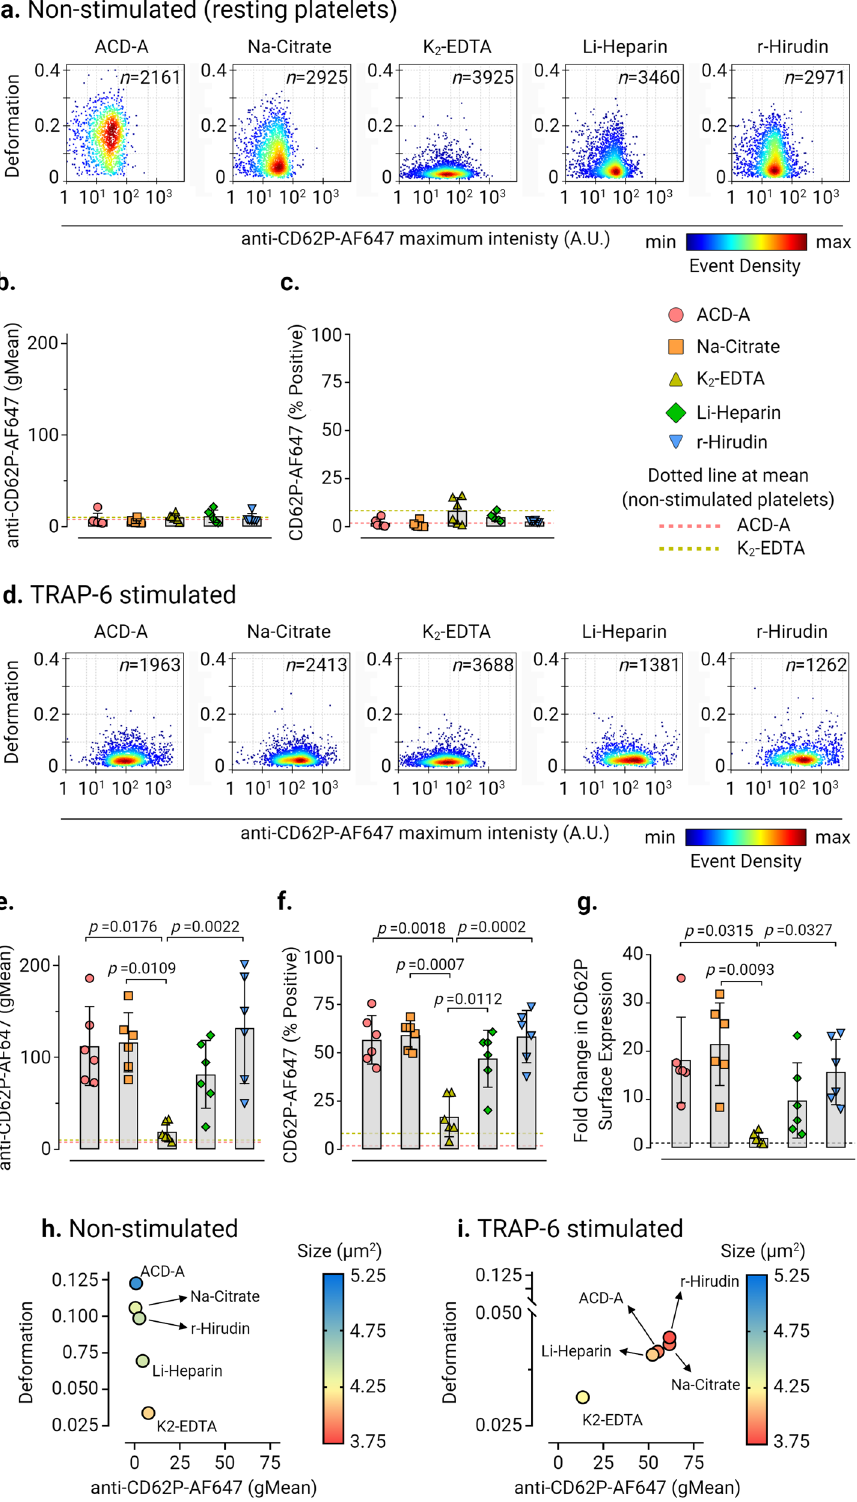
15.72 ± 6.76 in r-Hirudin in comparison to a fold change of 2.03 ± 1.16 in K 2 -EDTA (Fig. 2g). Multivariate analysis of continuous variables from RT-FDC data from non-stimulated and TRAP-6 sti- mulated platelets (Fig. 2h, i) further con fi rmed platelet deformation, size, and CD62P expression is strongly affected in K 2 -EDTA. Next, we assessed conformational changes in platelet integrin β α IIb 3 as a marker for platelet activation by PAC-1 antibody